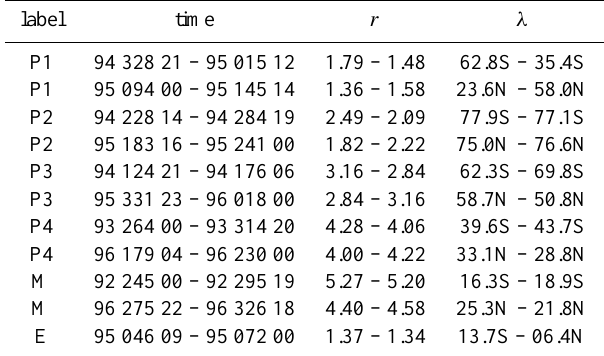
Table 1. Times (year, day, hour), distances ( r , a.u.), and latitudes ( λ , degrees) for the selected data